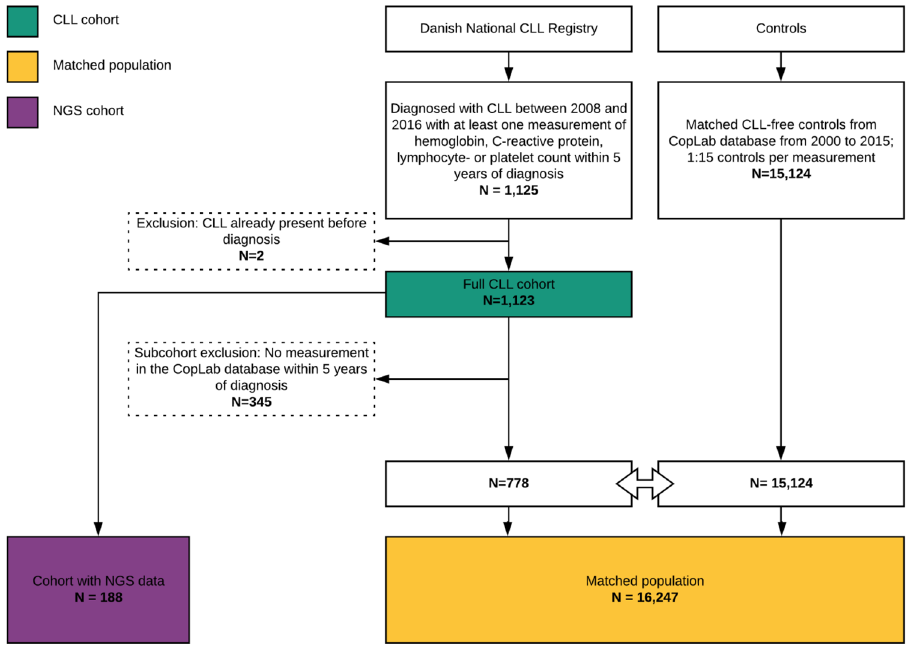
Fig. 1 Flow chart of patients included in the study. One thousand one hundred and twenty- fi ve persons were diagnosed with CLL. Two persons had a wrong diagnosis date in the register. Three hundred and forty- fi ve patients did not have any measurements in the CopLab database within 5 years of diagnosis resulting in 778 persons with CLL included in the study. The persons were matched on each biomarker with CLL-free control resulting in 15,124 controls. One hundred and eighty-eight persons had next-generation sequencing data available at the time of diagnosis. CLL chronic lymphocytic leukemia, NGS next-generation sequencing.